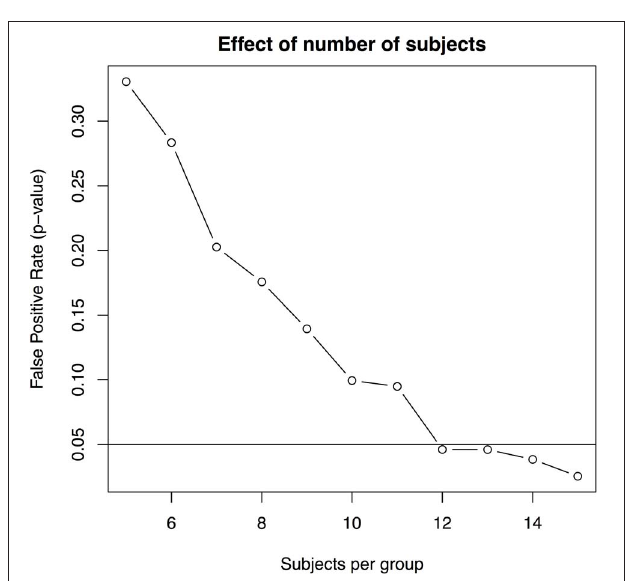
FIGURE 6 | The effect of subjects per group based on a standard deviation of 3.1% and four scans per